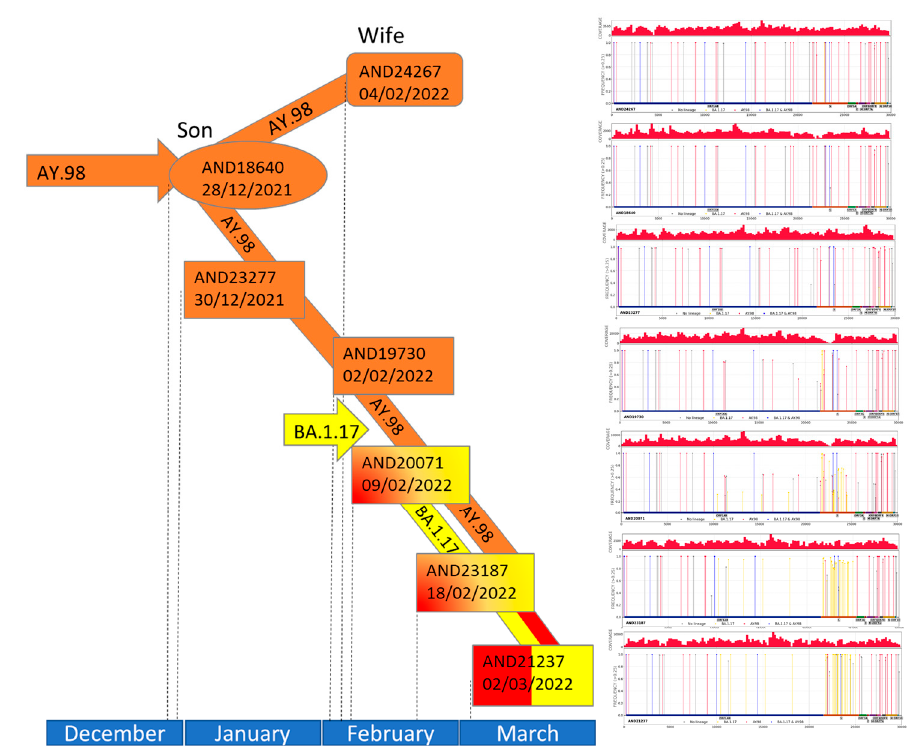
Figure 6. Representation in time scale of the distinct infections and co-infections by AY.98 and B.1.17 in the family in which the emergence of a recombinant was detected. The son, from which the first sequence of AY.98 was isolated is represented by an oval. The wife is represented by a rectangle with rounded corners and the rest of rectangles correspond to the patient. AY.98 is represented in red and B.1.17 in yellow. The last step between samples corresponds to the recombinant virus (arrow red and yellow). On the right part of the figure the plots of distribution of mutations corresponding to any of the samples sequenced can be found (Figure S5 has a version of the plots in a larger format).